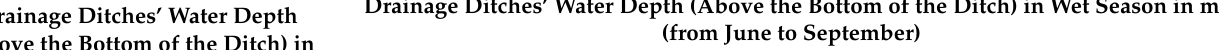
Table 2. Water-depth setting of the main drainage